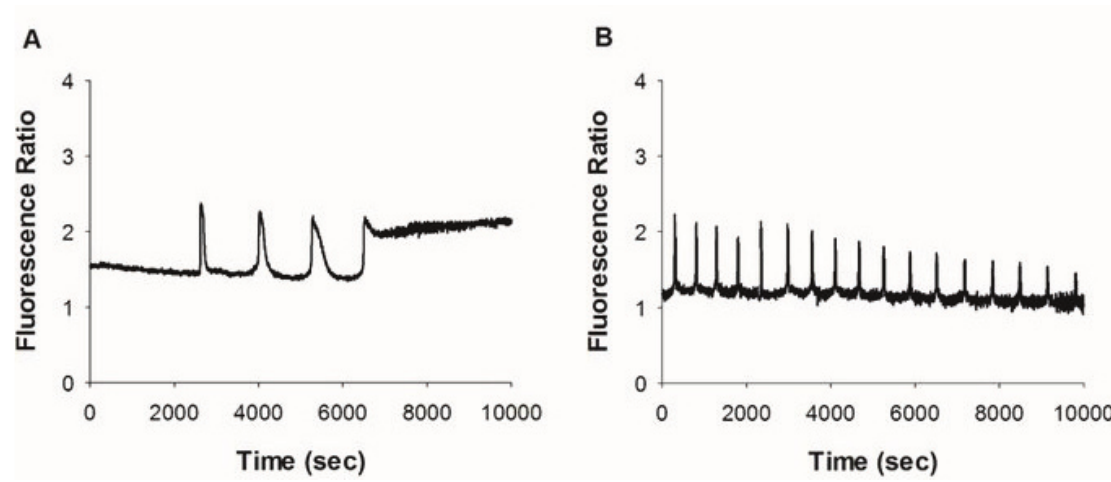
Figure 4. Effect of store-operated calcium entry (SOCE) activity on fertilization-induced Ca 2+ oscillations in pig eggs. A . Co-overexpression of Orai1 and stromal interaction molecule 1 (Stim1) leads to broader spikes with reduced frequency and that stop prematurely. B . Control situation. Reproduced with permission from Chunmin Wang, Lu Zhang, Laurie A. Jaeger, and Zoltan Machaty. Store- Operated Ca2+ Entry Sustains the Fertilization Ca 2+ Signal in Pig Eggs. Biol Reprod 2015; 93(1):25. DOI:10.1095/ biolreprod.114.126151 62